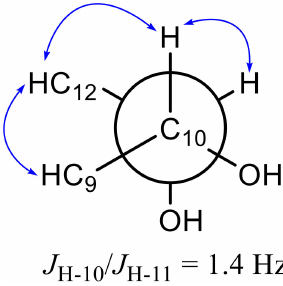
Figure 3. Key ROESY interactions of compound 2